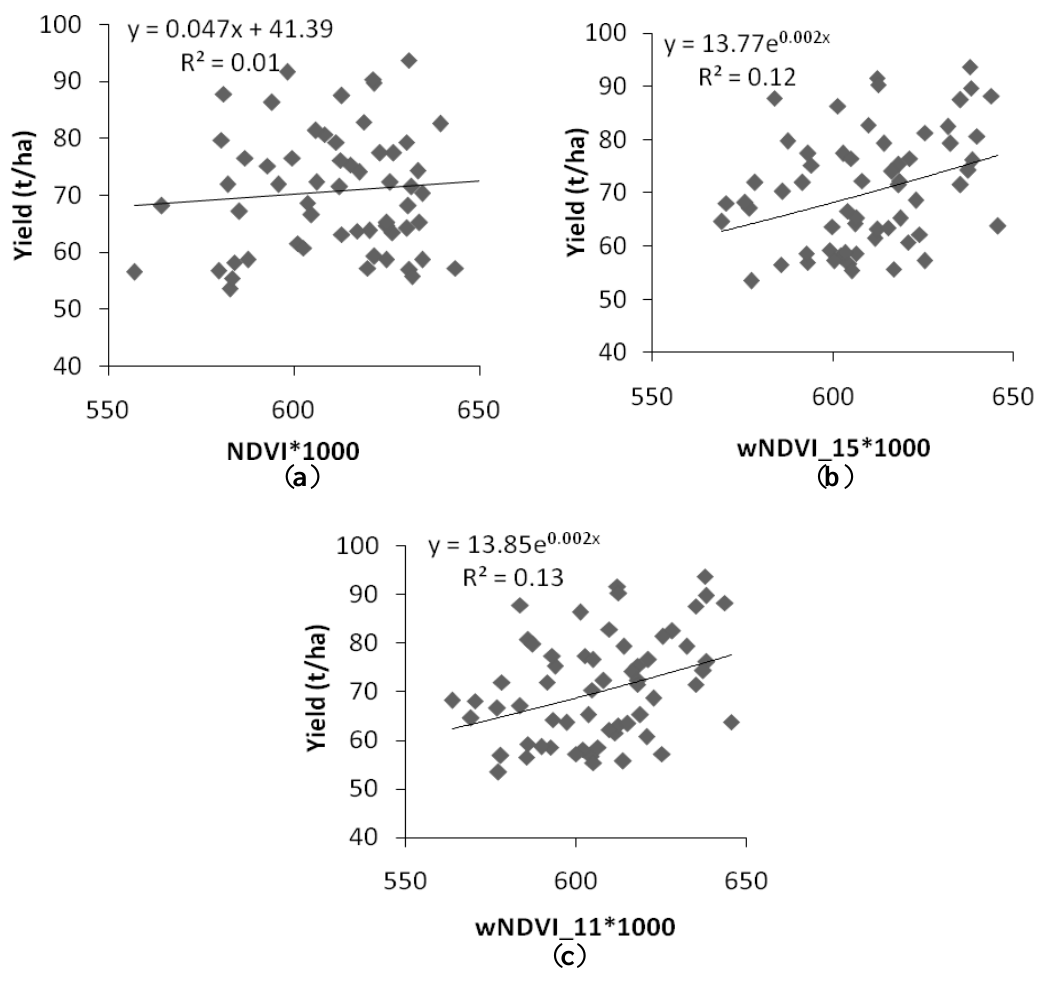
Figure 4. Relationship between ( a ) yield and annual NDVI, ( b ) yield and wNDVI_15, and ( c ) yield and wNDVI_11.